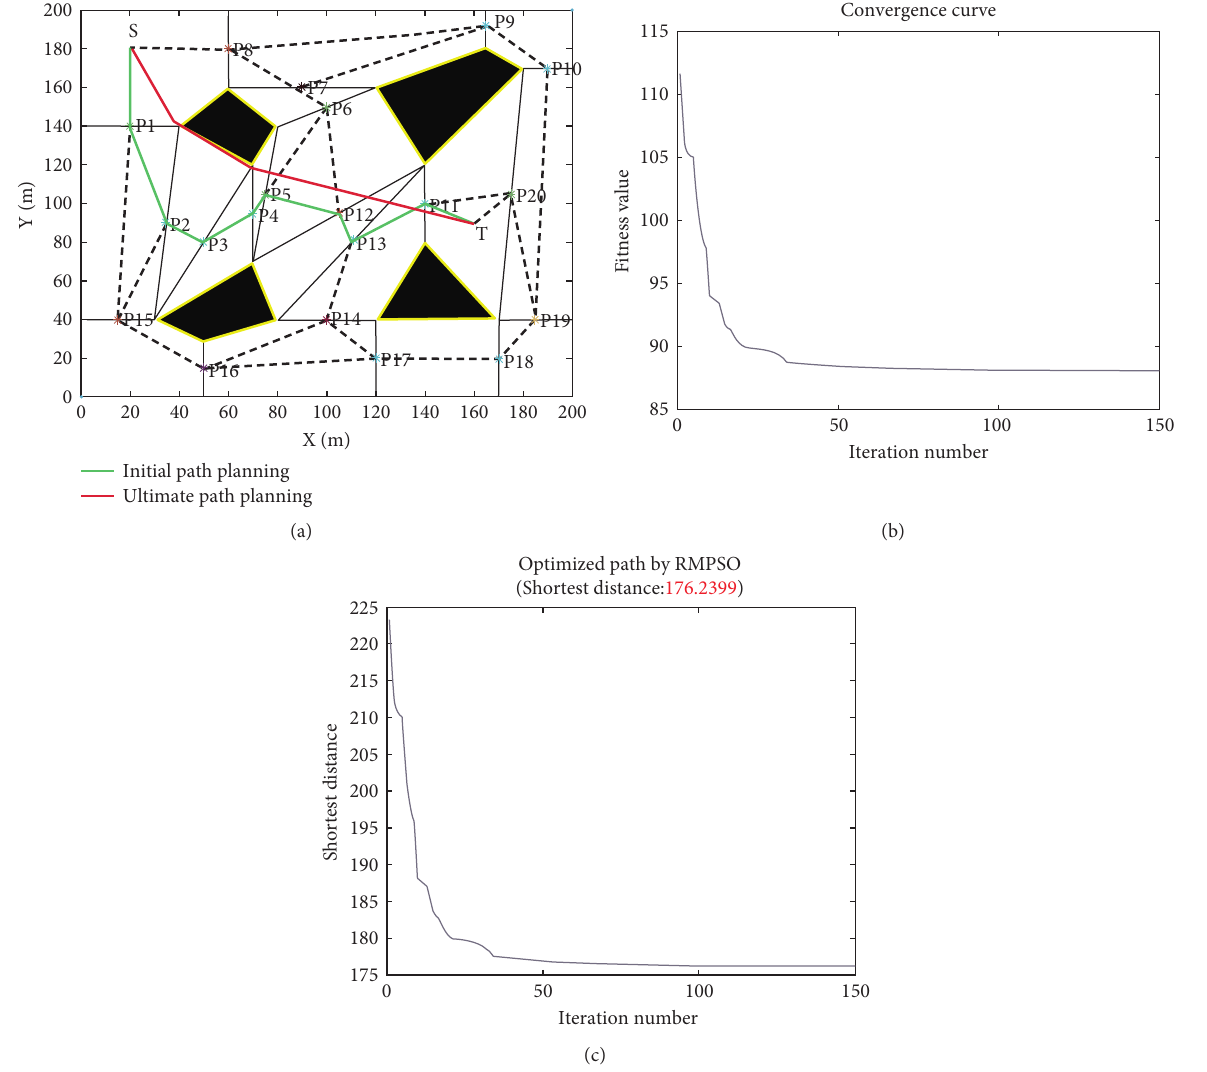
Figure 9: Optimized path through RMPSO. (a) Ultimate path planning (RMPSO). (b) Fitness convergence curve (RMPSO). (c) Path distance convergence curve